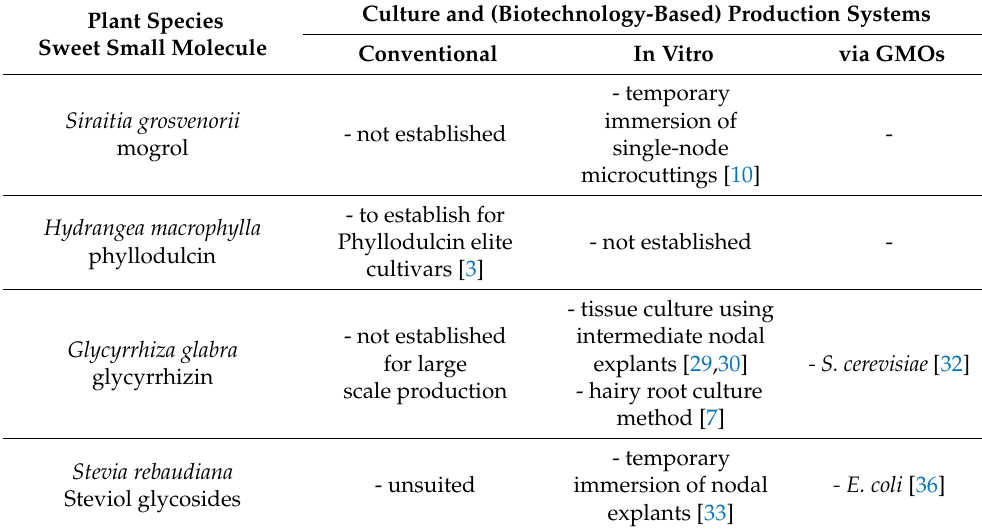
Table 1. Progress in sweet tasting molecule production